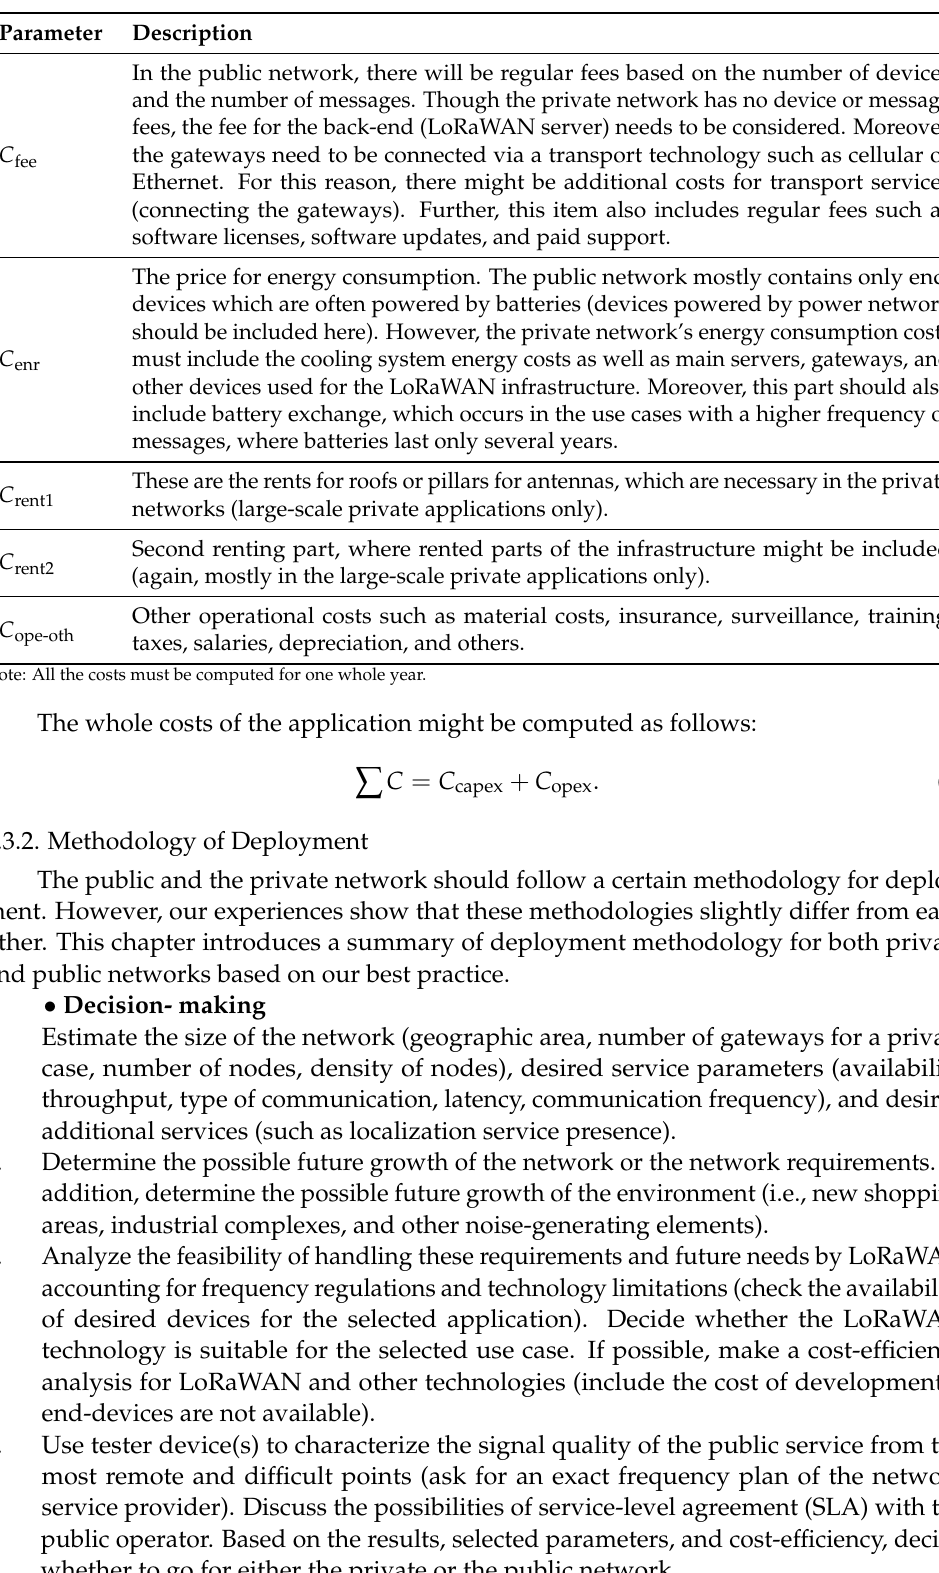
Table 6. The list of items constituting